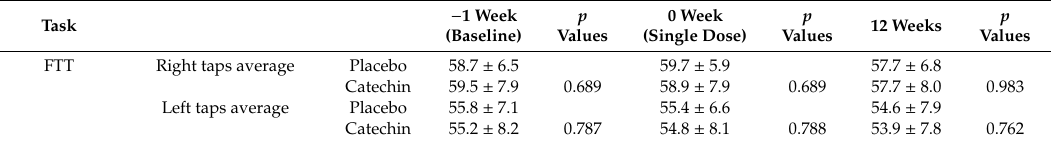
Table 7. E ff ects of green tea catechins on a motor function-related task.